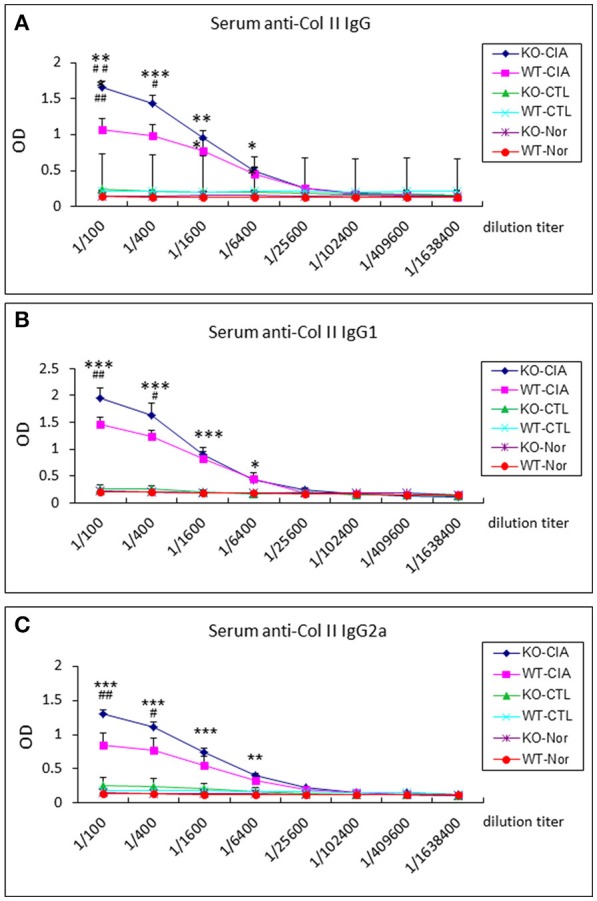
Deletion of Smad7 increases serum levels of anti-collagen II IgG subtypes in CIA mice by ELISA. Note that deletion of Smad7 significantly increases serum levels of anti-collagen II total IgG (A), IgG1 (Th2, (B)) and IgG2a (Th1, (C)) in CIA mice (CD-1). Data represent mean ± S.E. for groups of 8 mice. *p < 0.05, **p < 0.01, ***p < 0.001 compared to control; #p < 0.05, ##p < 0.01 compared to CIA-WT mice.